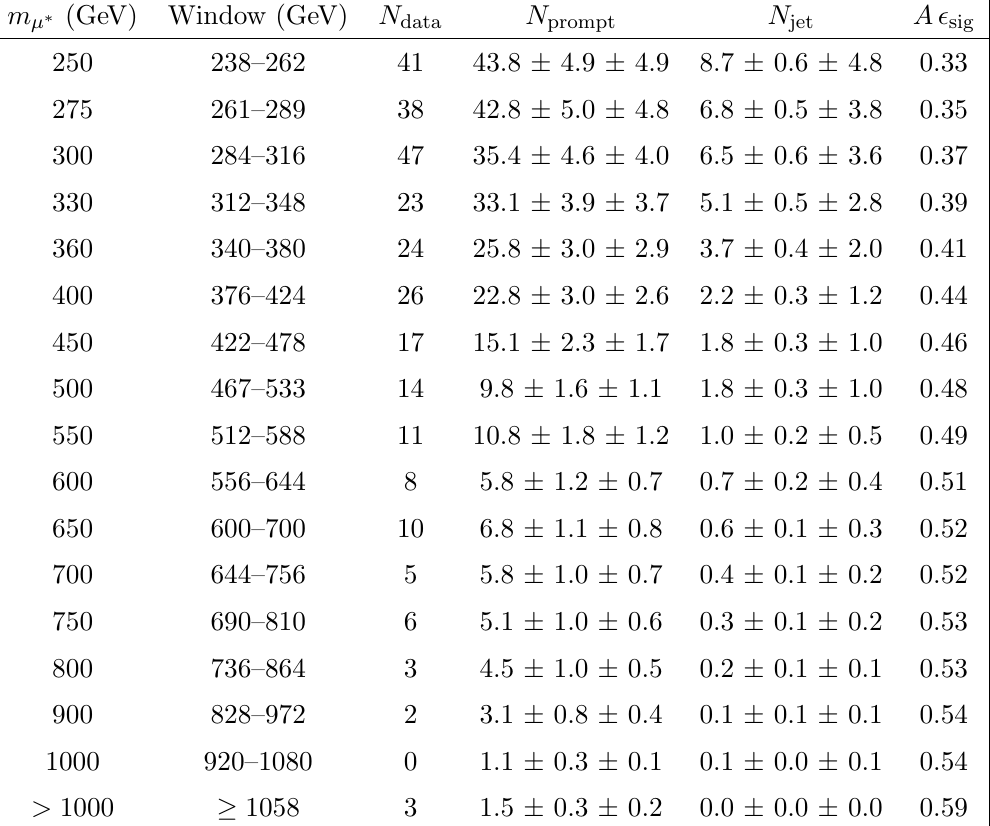
Table 3 . The observed yield and the SM prediction in the search window of the given m ‘ (cid:3) in the (cid:22)(cid:22)(cid:13) channel. The symbols N data , N prompt , and N jet represent the number of events in data, the prompt photon background prediction, and the jet background estimate, respectively, together with statistical and systematical uncertainties.